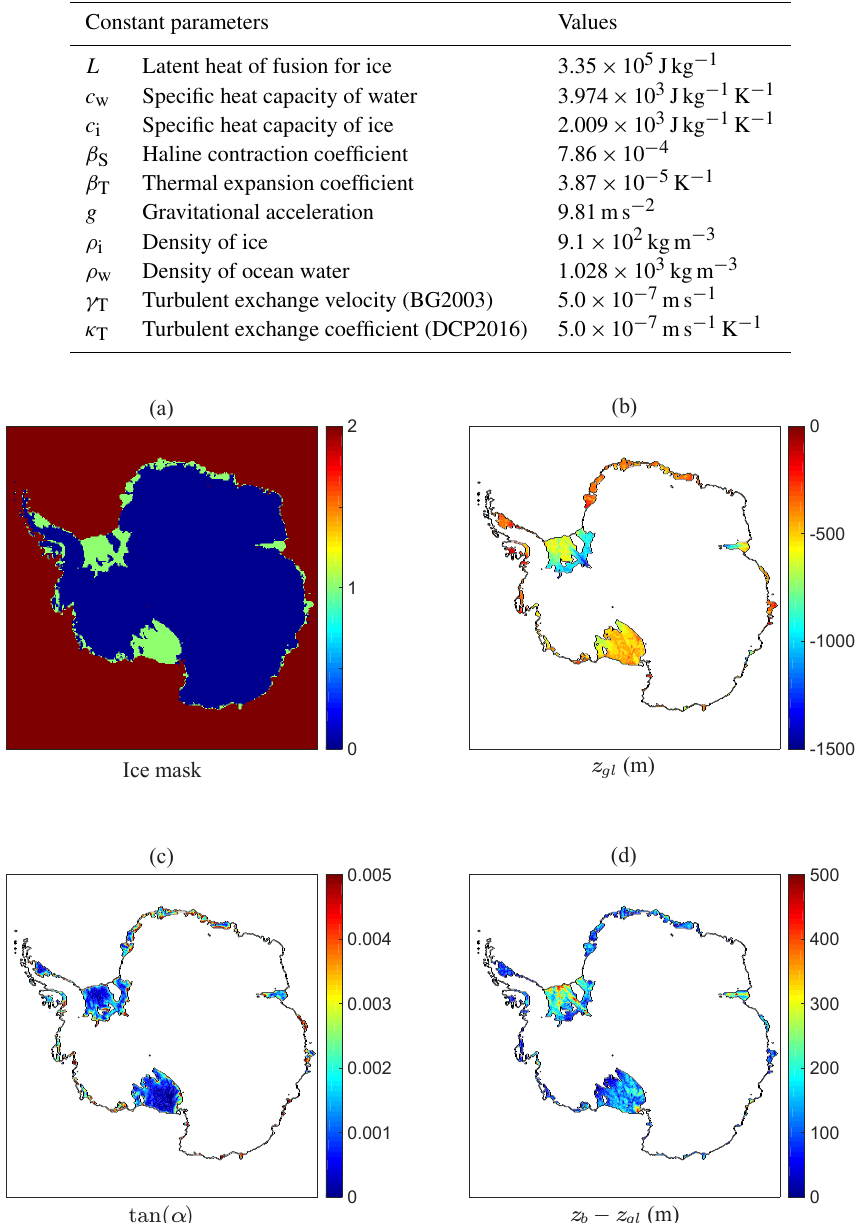
Figure 4. Effective plume paths under the Antarctic ice shelves as calculated by the algorithm of Sect. 2.3 using the Bedmap2 topographic data remapped on a 20km by 20km grid. (a) Ice mask according to Table 2. (b) The effective grounding-line depth z gl . (c) The effective slope tan (α) . (d) The difference between local ice-base depth and associated grounding-line depth, z b − z gl